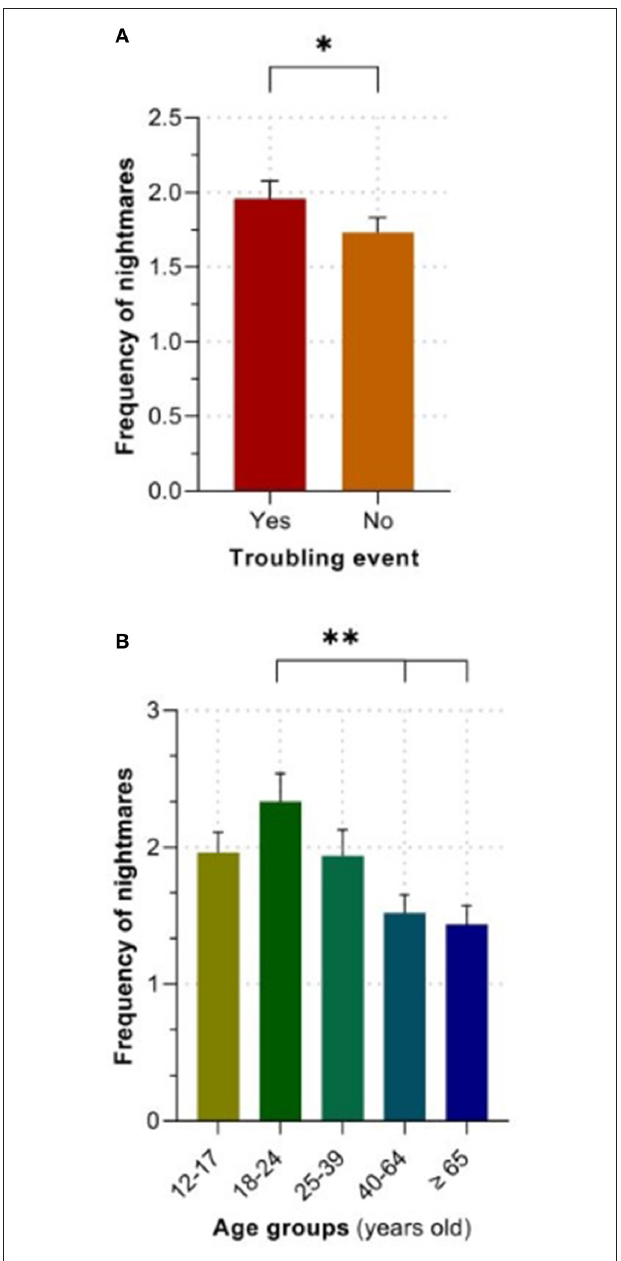
FIGURE 2 | Group differences in the frequency of nightmares. (A) . Main effect of the experience of troubling events over the past year. (B) . Main effect of age. The values are expressed as means ± SEM, N = 250. * p < 0.05; ** p < 0.01; *** p < 0.01.